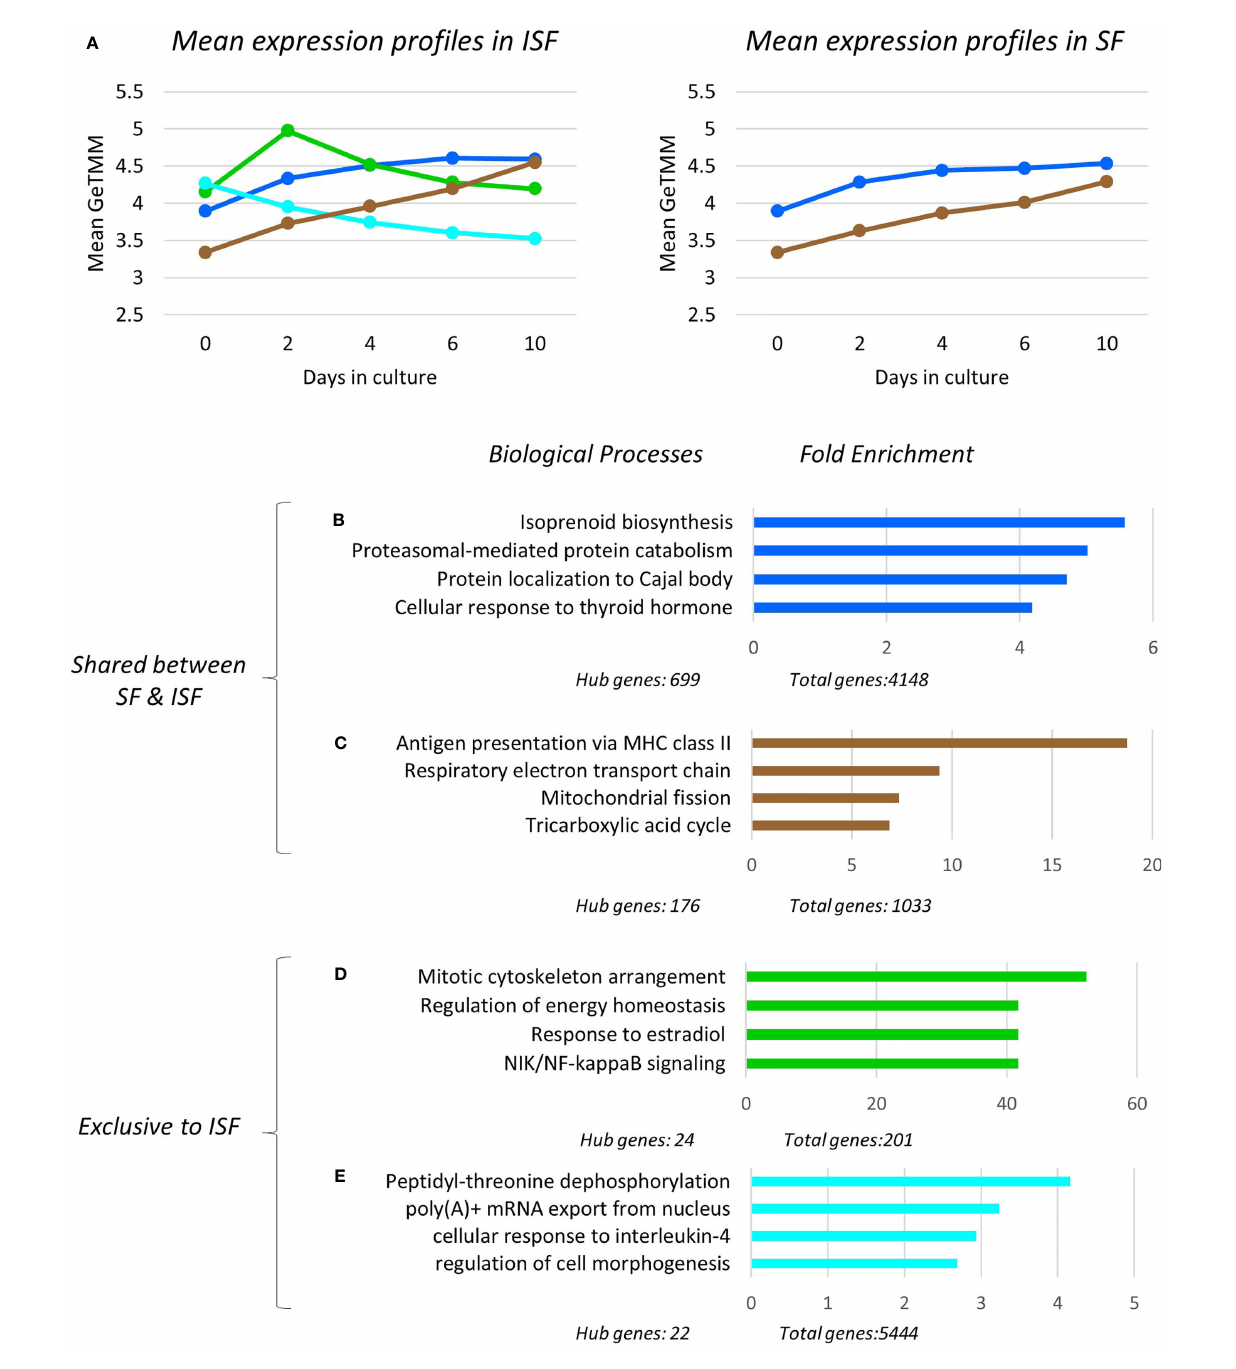
FIGURE 5 | Expression pro fi le, gene ontology enrichment and overrepresented biological processes within dominant modules. The green and turquoise modules were only signi fi cant in ISF and positively associated with IL-1 b quanti fi cation in conditioned ISF, and overall associated with pro-in fl ammatory mechanisms. The blue and brown modules were signi fi cantly associated to the timeline for both SF and ISF, while the blue module was positively associated to CD86 expression in ISF. (A) Mean expression pro fi les of signi fi cant modules in SF and ISF derived from all transcripts in each cluster. In ISF, the presence of the pro-in fl ammatory green and turquoise modules are associated to increased mean expression of the homeostatic/pro-resolving blue and brown modules. Overrepresented Biological Processes (BPs) in the blue (B) , brown (C) , green (D) , turquoise (E) modules and their corresponding fold enrichment. The complete list of signi fi cant modules, BPs and related genes for each module is presented in Supplementary Tables 2, 3